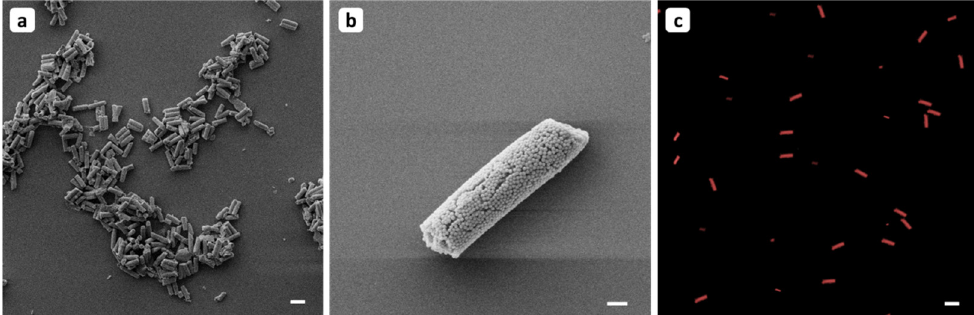
Figure 1. The microparticle formulation composed of mSNP functionalized with rhodamine B visualized ( a , b ) by SEM and ( c ) by CLSM. In all three images, the cylindrical shape can be seen. In ( a ), the particles are not well dispersed due to drying effects. With higher magnification used in ( b ), the nanostructure of the formulation is visible. ( c ) The formulation was visualised by CLSM with λ ex = 545 nm, λ em = 567 nm, dispersed in water. The homogeneous particle dispersion is clearly visible, and the fluorescent signal indicates that the functionalization with rhodamine B was successful. Representative sections were used for all images. Scale represents 10 µ m for ( a , c ) and 1 µ m for ( b ). The brightness of the CLSM image ( c ) has been increased for better visibility.